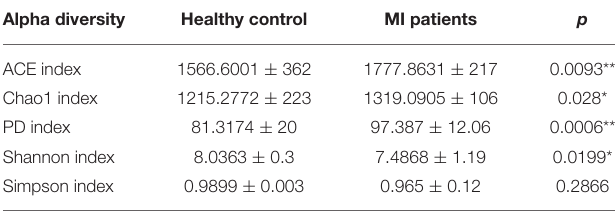
TABLE 2 | Alpha diversity indices between both